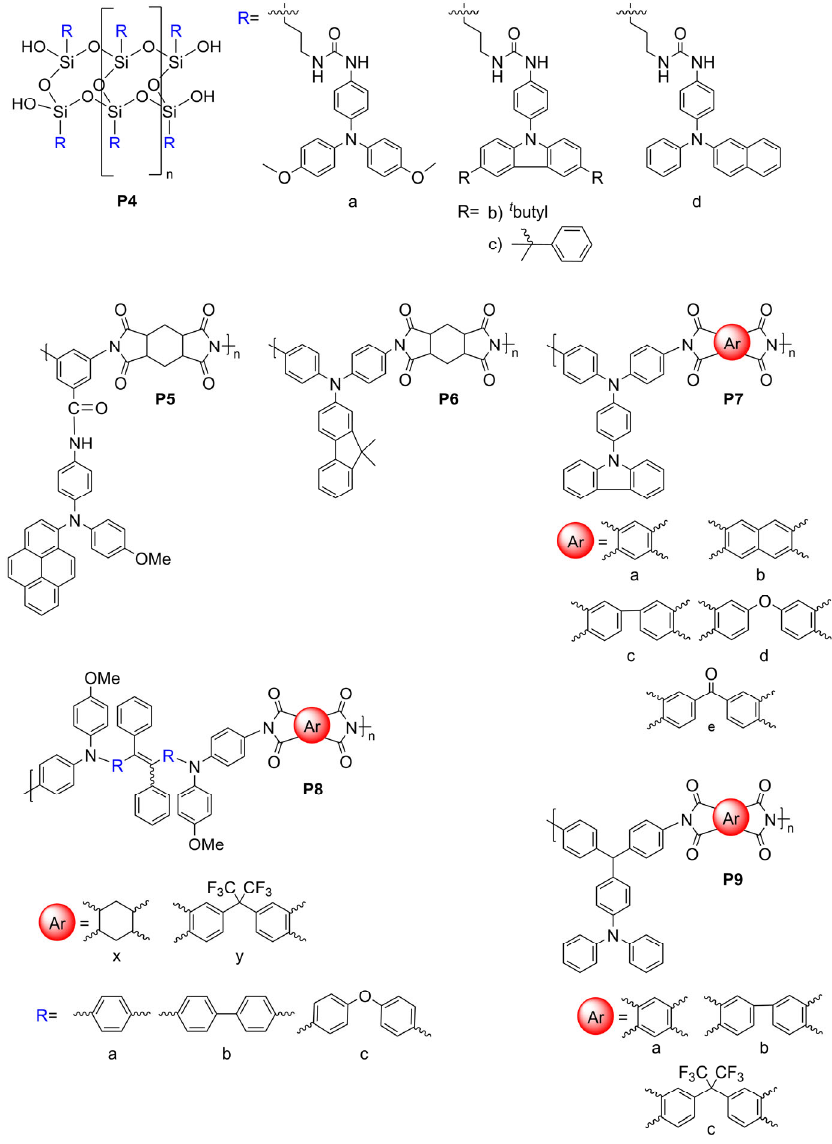
Figure 13. Polyimide derivatives used as electrofluorochromic materials [138–143].